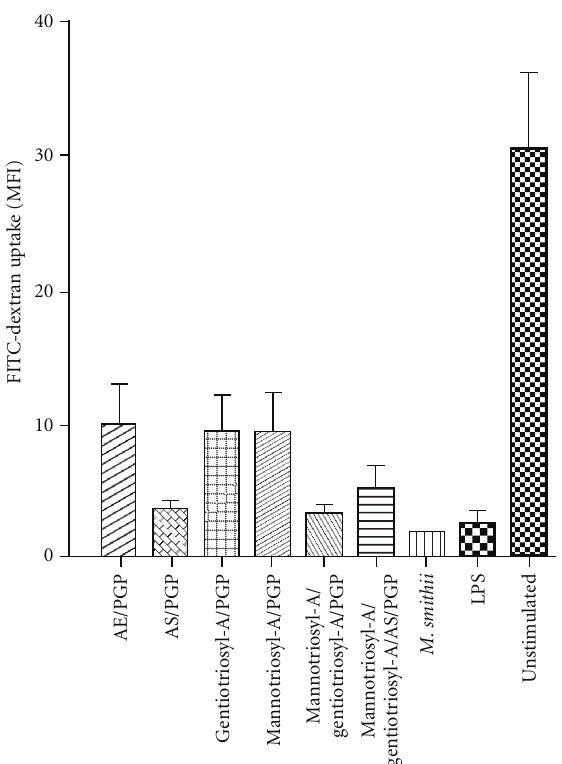
Figure 8: Maturation of dendritic cells (DCs) upon treatment with archaeosomes as measured by decrease of FITC-dextran uptake. Bone marrow DCs treated with archaeosomes in vitro were compared for their ability to take up FITC-dextran. The results depict the mean Δ MFI (37–4 ◦ C). Data represent means ± SD of triplicate cultures as